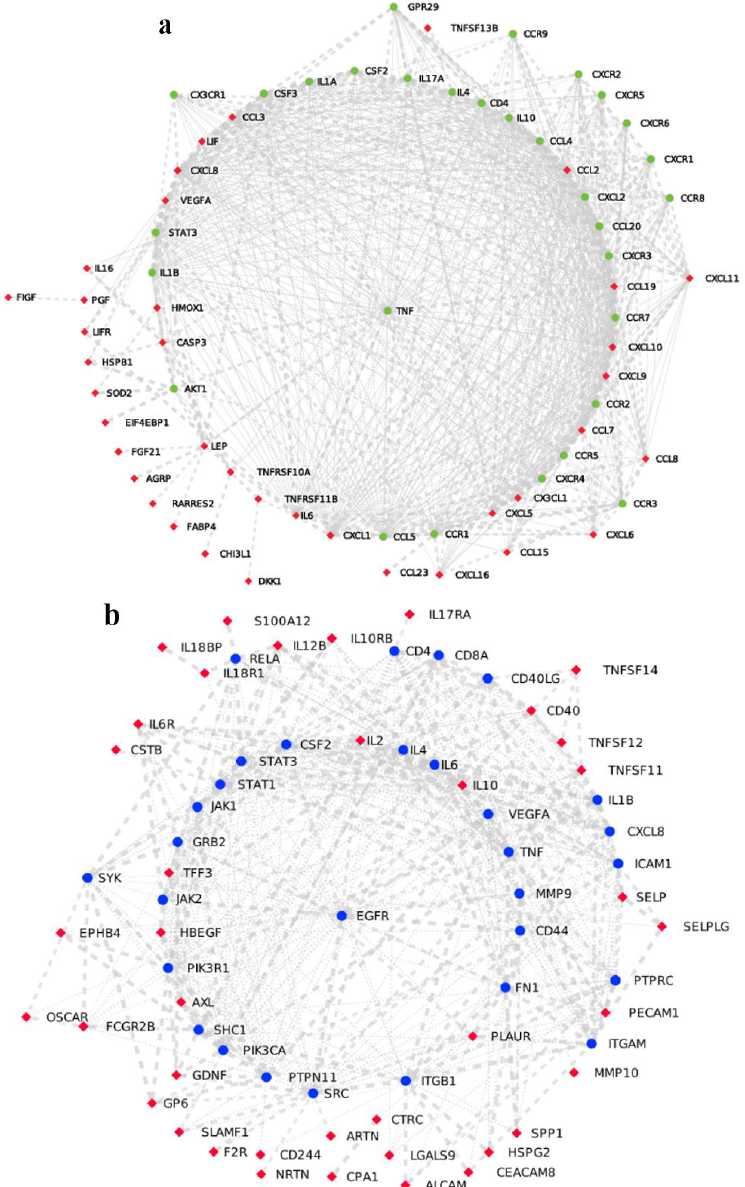
Figure 2. A protein–protein interaction network associated with ( a ) bacterial sepsis, where highly expressed genes are denoted in red and their interacting partners denoted in green and in ( b ) ARDS induced by COVID-19, where highly expressed genes are denoted in red and their interacting partners denoted in blue.